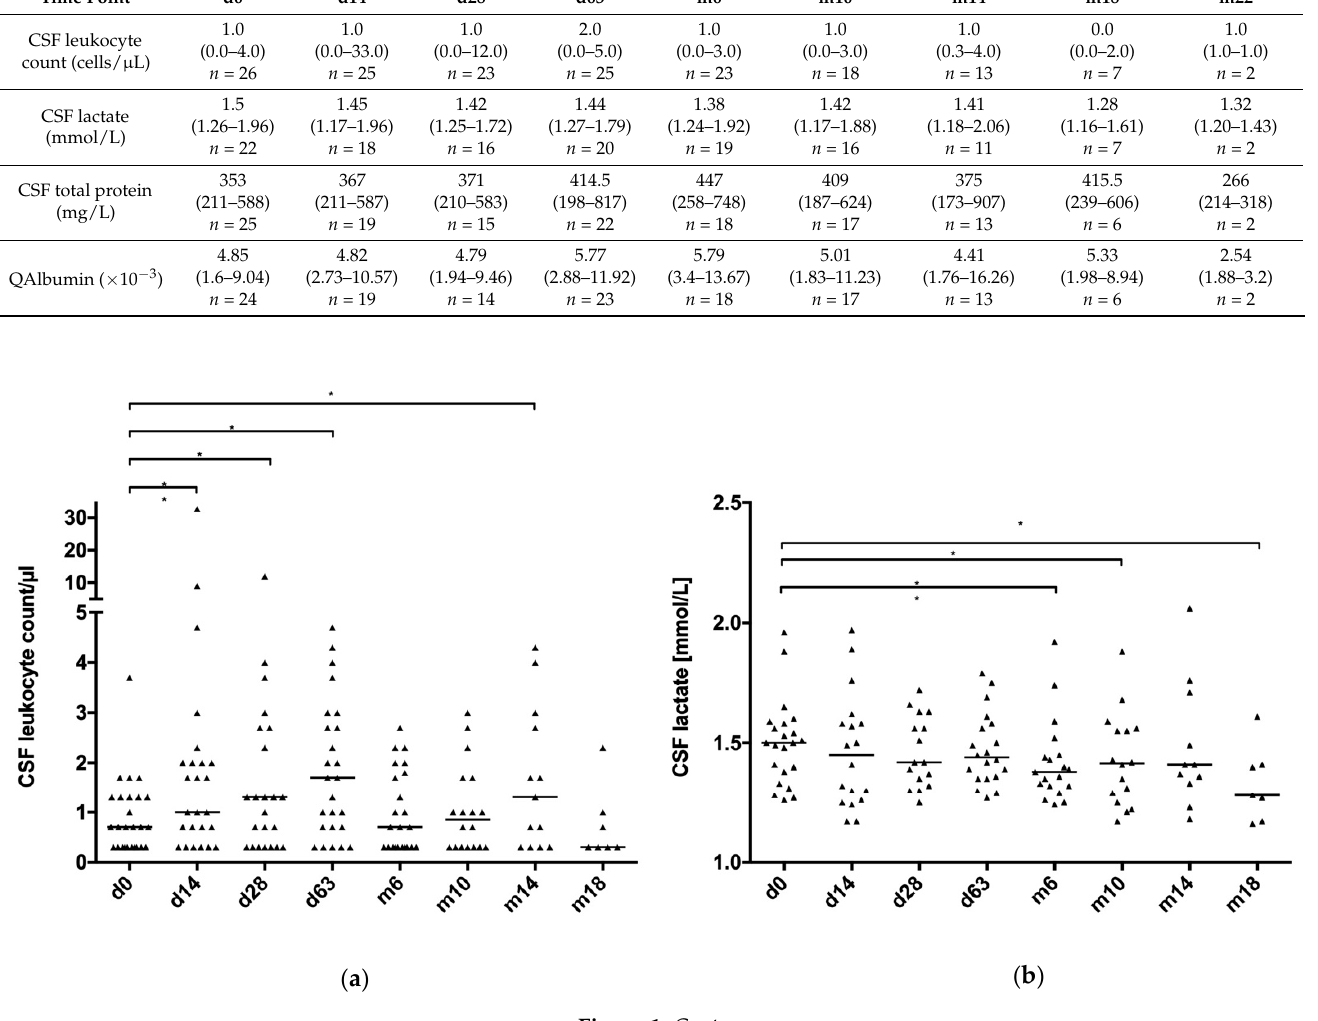
Figure 1. CSF routine parameters during nusinersen therapy (d0 to m18). (a ) CSF leukocyte count and lactate, (b) CSF 201 lactate, (c) CSF total protein, and (d) QAlbumin. Values displayed as scatter plots with the median. CSF: cerebrospinal 202 fluid; d: day; m: month; QAlbumin: CSF/serum albumin quotient. *: p ≤ 0.05; **: p ≤ 0.01; ***: p ≤ 0.001. 203